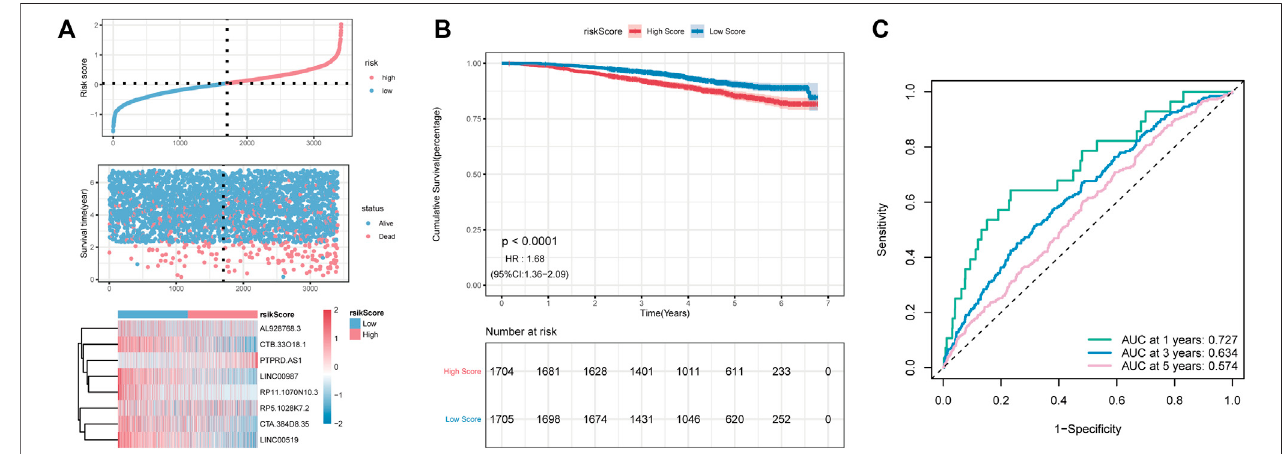
FIGURE7| TheexternaldatasetGSE96058validatestheriskmodel. (A) :distributiondiagramofriskscore; (B) :survivalcurve; (C) :ROCcurveat1,3,and5 years.